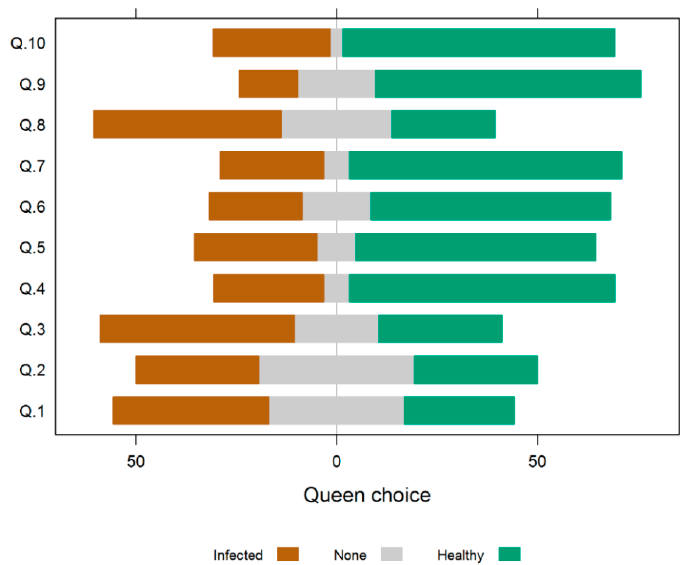
Figure 4. Honey bee queen tendency to associate with healthy or infected workers. For each queen (Q1–Q10), the percentage of time that this queen was in contact with infected workers, healthy workers, or neither group, is indicated by the length of the colored bars. Even though the majority of queens tend to spend more time with healthy workers, the overall preference for healthy workers was not statistically significant ( p = 0.058), Brown bars to the left = percentage time spent with infected workers, green bars to the right = percentage time spent with healthy workers. The order of independent trials (Q1–Q10) corresponds to the order in Figure 3).